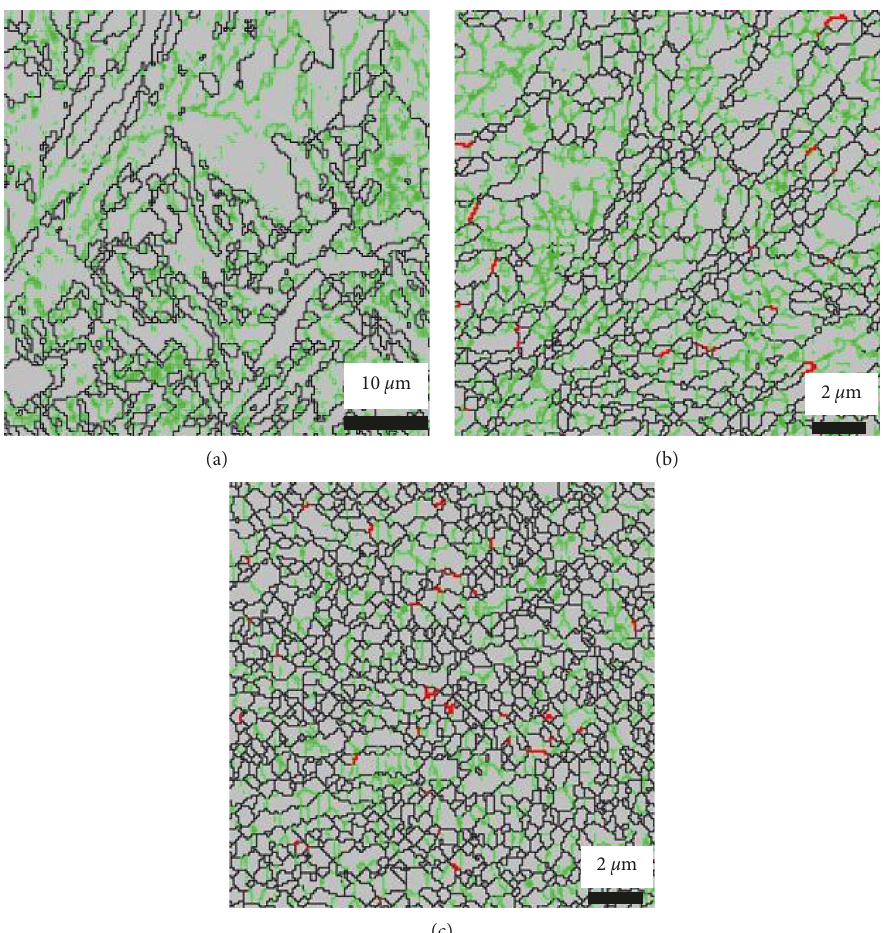
Figure 5: (a) Grain boundaries maps in (a) sample 4, (b) region 2 of sample 2, and (c) region 3 of sample 3.